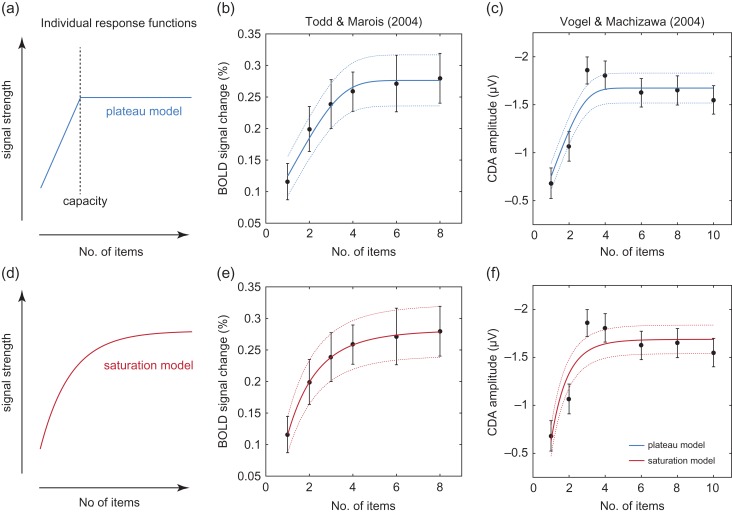
Models and fits. (a) Example of an individual response function relating set size to signal strength under the plateau model. According to the plateau model, signal strength increases until the set size matches the individual’s capacity: further increases in set size do not affect the signal strength. (b) Black data points indicate group mean data from an fMRI signal in IPS/IOS (Todd and Marois 2004). Errorbars indicate ±1 SE. Solid lines show fits of the plateau model to group means, and dotted lines show SEs predicted by the model. Note that the plateau model predicts a smooth transition to plateau due to averaging across participants with different capacities. (c) Black data points indicate group mean data from a recording of the CDA (Vogel and Machizawa 2004), blue lines show fit of the plateau model. (d) Individual response function under the saturation model. According to this model, signal strength increases continuously, but each increment in set size has less effect than the one before: signal strength does not reach a maximum at any set size. (e, f) Data as in (b, c), red lines show fit of the saturation model.